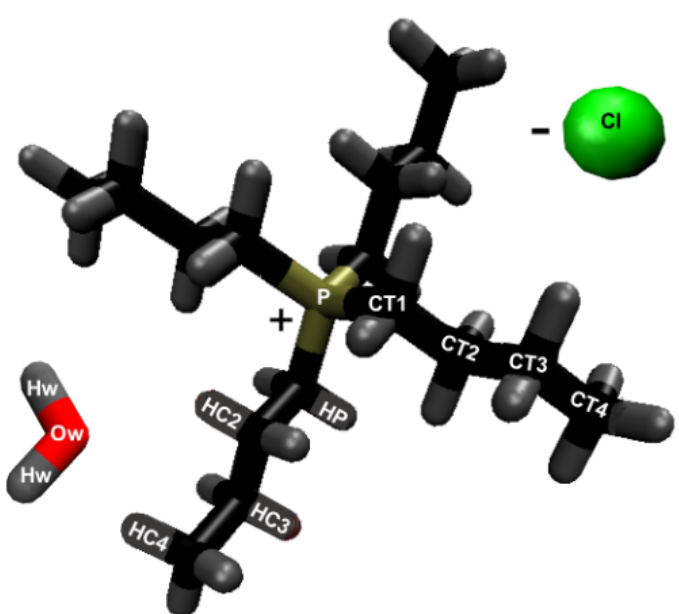
Figure 3. Atomic labeling for tetrabutylphosphonium (TBP), chloride (Cl), and water. The tan, black, red, and gray atoms are phosphorus, carbons, oxygens, and hydrogens, respectively. ( Left ) water molecule; ( center ) TBP molecule; ( right ) chloride molecule. For the TBP molecule, every atom was not labeled, but all butyl arms have the same symmetrical labeling. The right butyl arm is labeled with only the carbon atom labeling, while the bottom arm only has the hydrogen atoms labeled. The TBP atoms are labeled as follows: the CT’s are the carbons; the HP’s and HC’s are the hydrogens; the P is the phosphorus. The water’s atoms are Ow and Hw for oxygen and hydrogens, respectively. The chloride is labeled as Cl